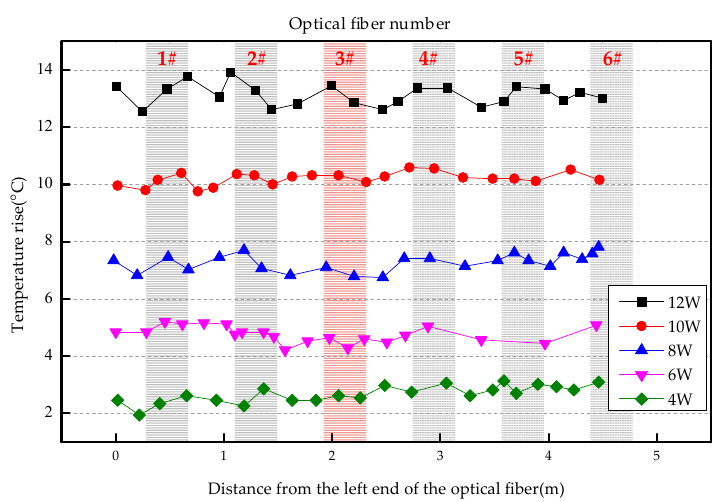
Figure 7. Temperature increase versus seepage flow velocity of 0 mm/h.